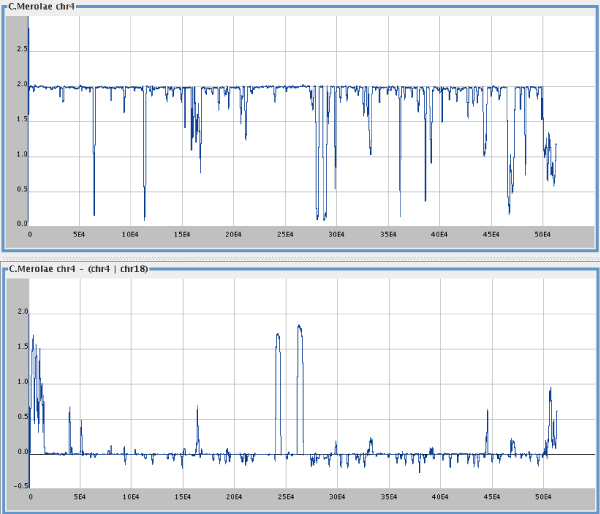
Plot for C. merolae chromosome 4 and its difference from chromosome 4 given 18, smoothing window 1000. Information sequence from ARM for C. merolae chromosome 4 at top; and the resulting information sequence after subtracting information sequence for chromosome 4 given 18. Smoothing windows of 1000 bp.